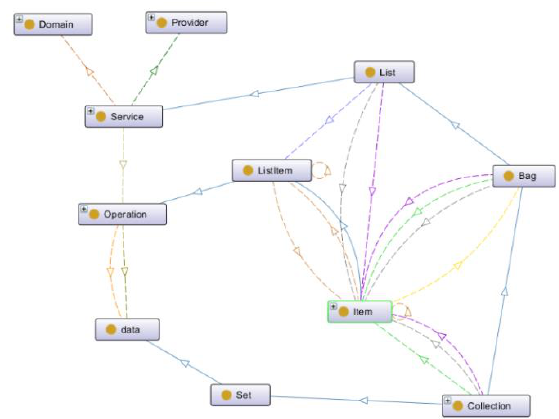
Figure 1. Visualisation of the ontology structure via